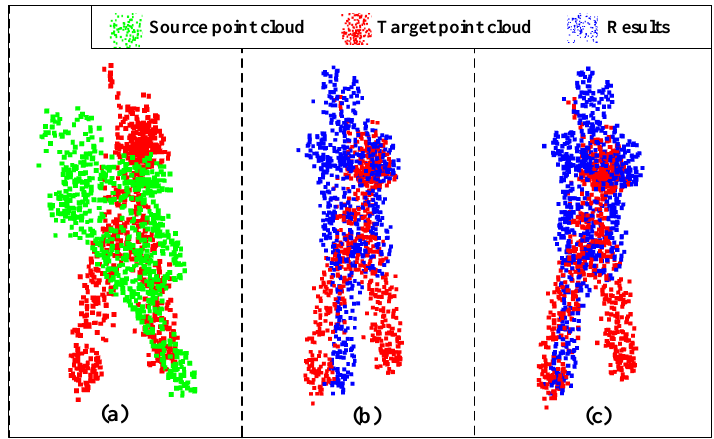
Figure 8. Registration visualization under 300 epochs: ( a ) input; ( b ) ROPNet; ( c ) ours.